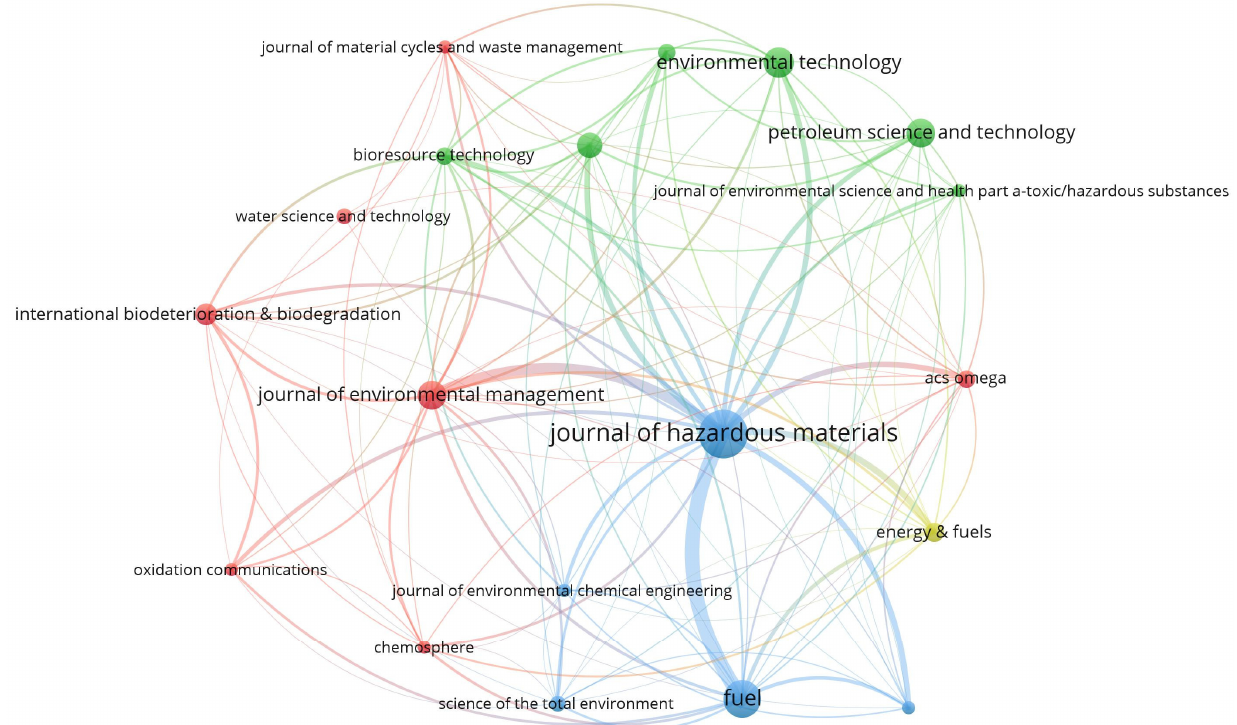
Figure 2. A diagram showing the inter-citation network of oily sludge-related articles published in the journals with a total number of citations more than five times for all relevant articles published in that journal to July 2022. The larger the size of the circle, the higher the number of citations; circles with the same color indicate more frequent inter-citation among the journals.